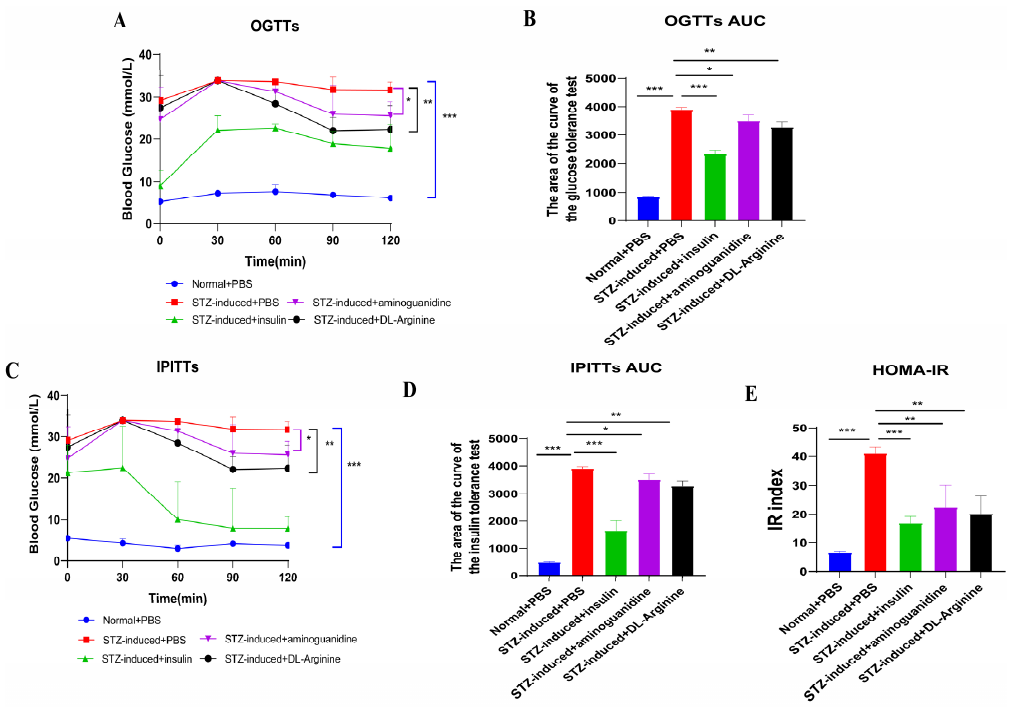
Figure 9. Effect of DL-arginine on rats’ glucose tolerance and insulin tolerance. ( A ) Rat glucose tolerance tests (OGTTs). Individual glucose tolerance was assessed by oral glucose tolerant tests.